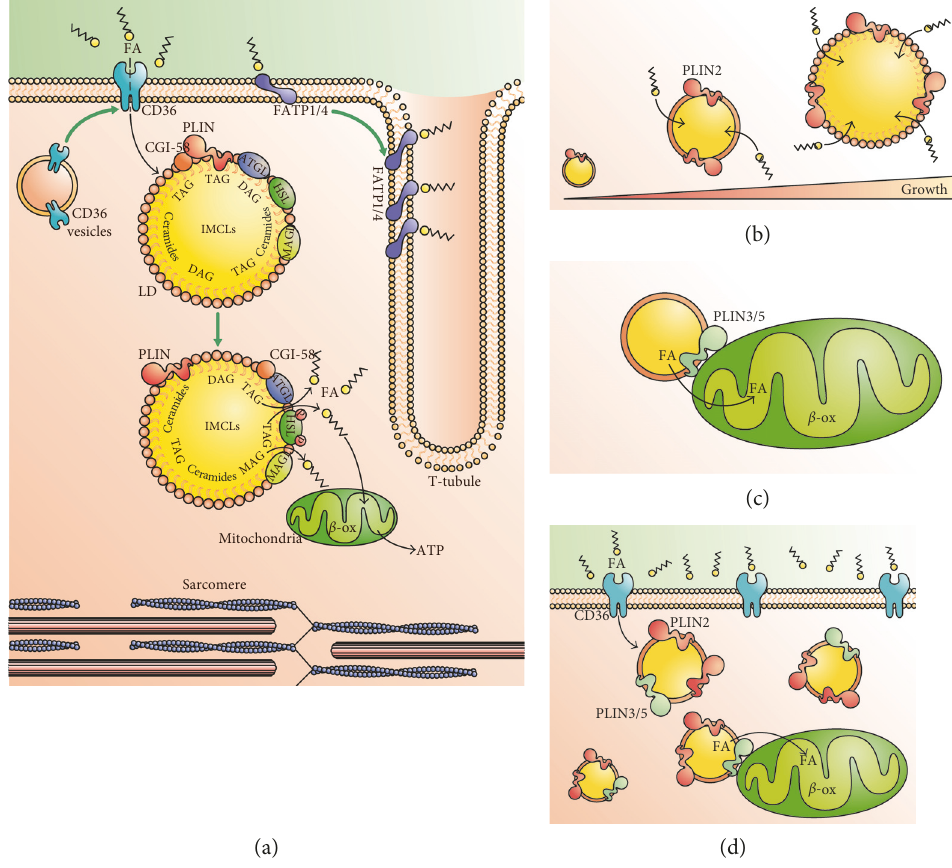
Figure 1: FA fl ux in skeletal muscle and role of perilipins. (a) Schematic representation of FA uptake and deposition in lipid droplets (LD). FA uptake is mediated by FAT/CD36, located in the plasmalemma. FATP1/4 are located in the plasmatic membrane and cooperate with FA intake and metabolism. Movement of CD36 to the plasmatic membrane and an increment in FATP1/4 can be triggered by insulin or contraction (green arrow, see text for details). Once inside the cell, FAs can be accumulated in LDs as acyl-glycerides (TAG, DAG). Perilipins (PLINs) coat the LD membrane, along with the lipases ATGL and HSL and the coactivator CGI-48. In response to contraction (green arrow), ATGL activity increases, as a result of dissociation from PLINs, while HSL is activated by PKA-dependent phosphorylation. This leads to increased FA fl ux to cytosol and mitochondria, undergoing further β -oxidation ( β -ox) and ATP synthesis. (b) Main function of PLIN2 in skeletal muscle. PLIN2 coats LD and promotes FA intake, leading to increased size of LD. (c) PLIN3 is part of LD mitochondria contact sites, promoting e ffi cient transfer of FA from LD to mitochondria for oxidation. (d) In cases of excess plasmatic FAs, such as obesity and T2DM, FAs uptake into skeletal muscle is increased. Higher levels of PLIN2 promote an increase in both size and number of LDs. Furthermore, increased levels of PLIN5 foster FA metabolization inside